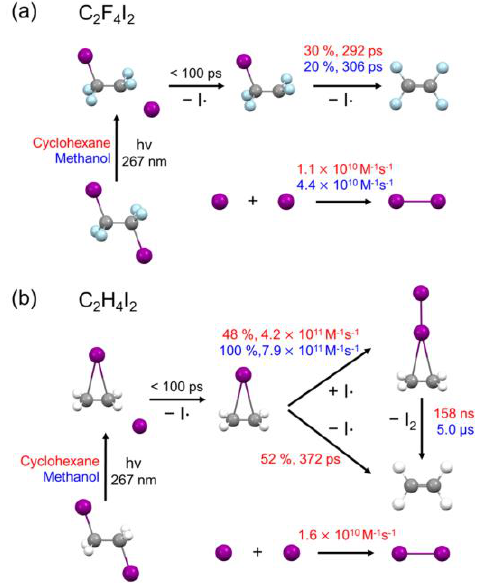
Figure 6. Comparison of photodissociation dynamics of ( a ) C 2 F 4 I 2 and ( b ) C 2 H 4 I 2 in cyclohexane and methanol. Kinetic parameters in cyclohexane and methanol are shown in red and blue, respectively. While the reaction pathways and the associated kinetics of C 2 H 4 I 2 photodissociation substantially vary depending on the solvent, the photodissociation of C 2 F 4 I 2 did not exhibit such strong dependence. For both C 2 F 4 I 2 and C 2 H 4 I 2 , the structures of the reaction intermediates did not change much with the change in